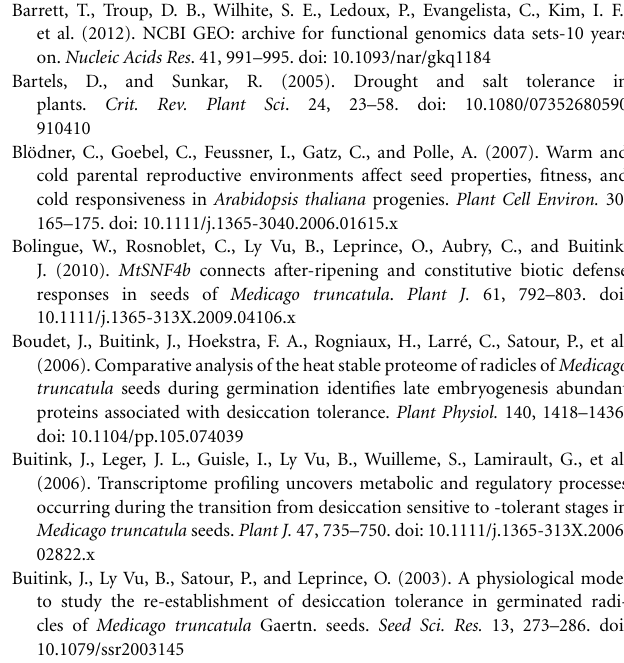
Table S4 | Transcript levels of two glutamyl cysteine ligase genes (Medtr5g010210.1 and Medtr5g010230.1) after the re-induction